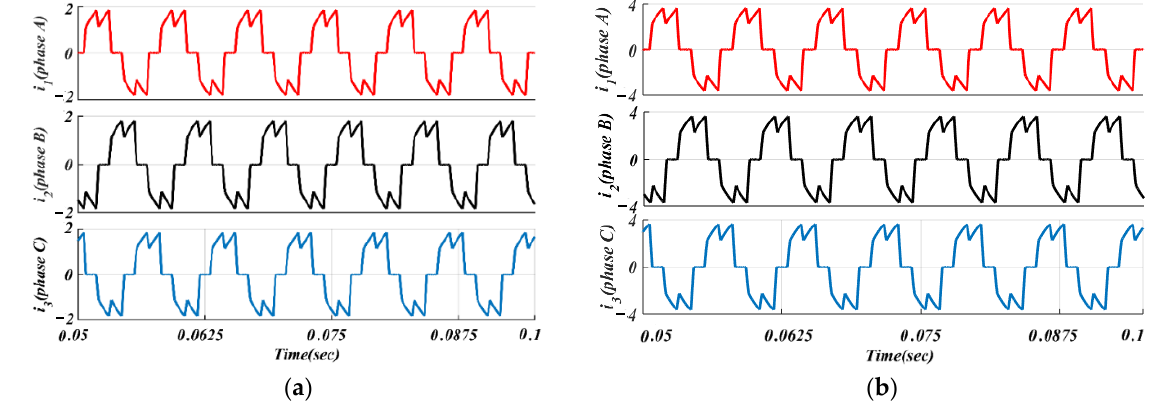
Figure 9. Framework for MATLAB/Simulink and experimental setup of the proposed control strategy for the BLDCM drive.